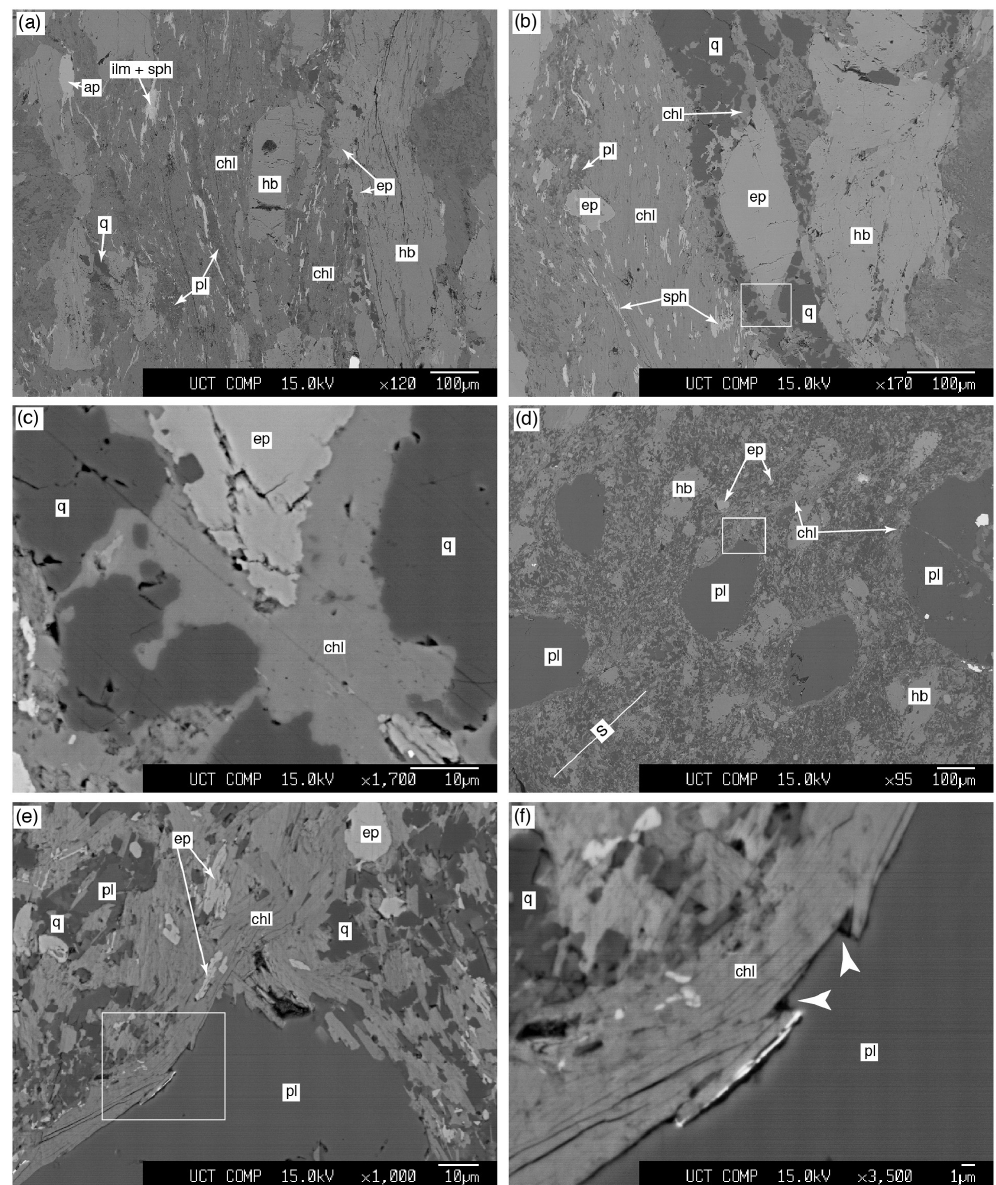
Figure 4. Backscatter electron images. (a) Mineral elongation and alignment in KMZ29. (b) σ -clast of epidote showing preferential growth of chlorite in its pressure shadows. (c) Detail of the pressure shadow outlined by the box in (b) . (d) Rounded plagioclase and hornblende clasts enveloped by a fine-grained and foliated chlorite–epidote–plagioclase–quartz assemblage in KMZ30. Note the preferred growth of chlorite in the pressure shadows of plagioclase and hornblende. (d) Close-up of the area outlined in (d) , demonstrating chlorite–epidote growth in the pressure shadow of plagioclase. (e) Close-up of the plagioclase–chlorite grain boundary outlined in (e) , showing the presence of pore spaces at grain boundary irregularities